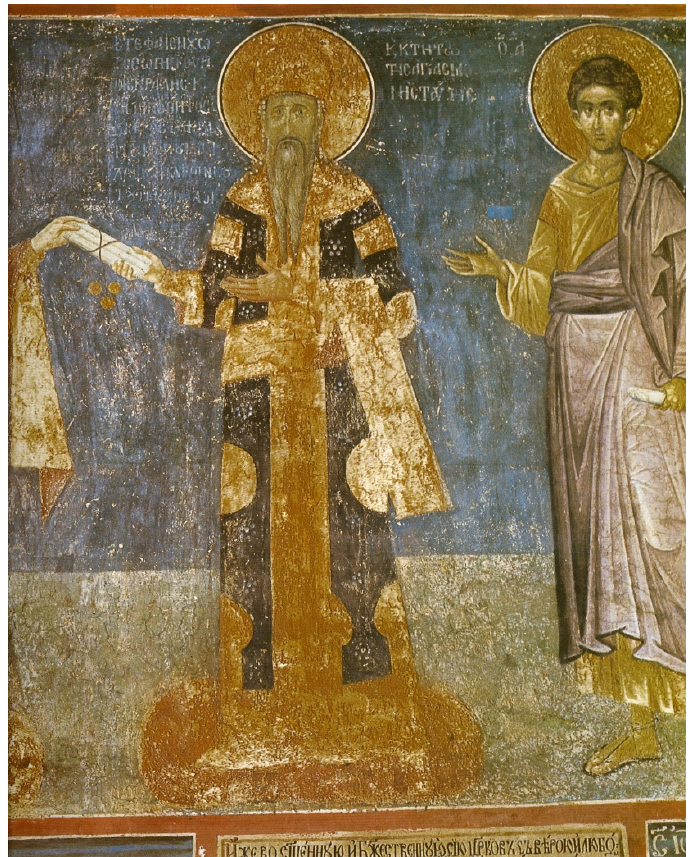
Figure 8. King Milutin, fresco, 1321. Church of the Presentation of the Virgin, Monastery of Chilandar, southern part of the second zone of the east wall of the narthex. Courtesy Gallery of Frescoes, Belgrade.